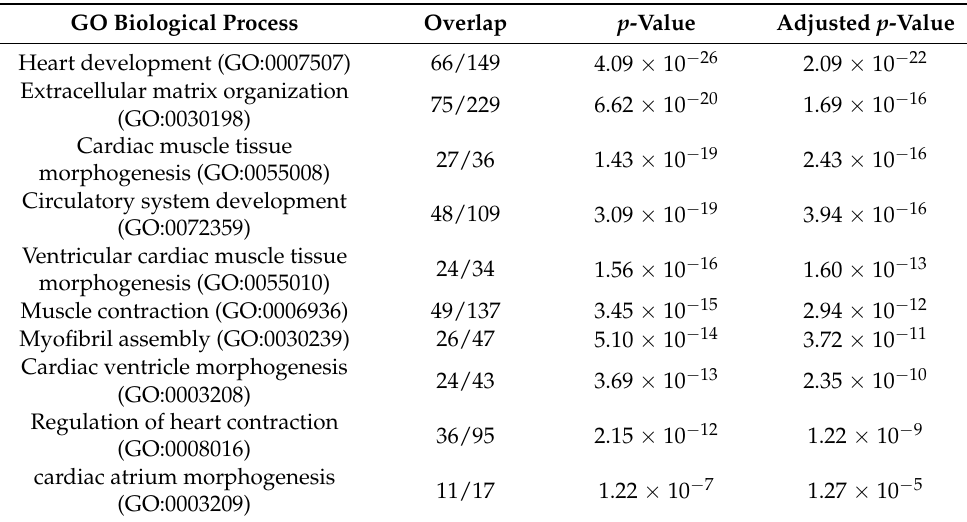
Table 1. Top 10 significantly enriched gene ontology biological processes in significantly upregulated CMs transcriptome.